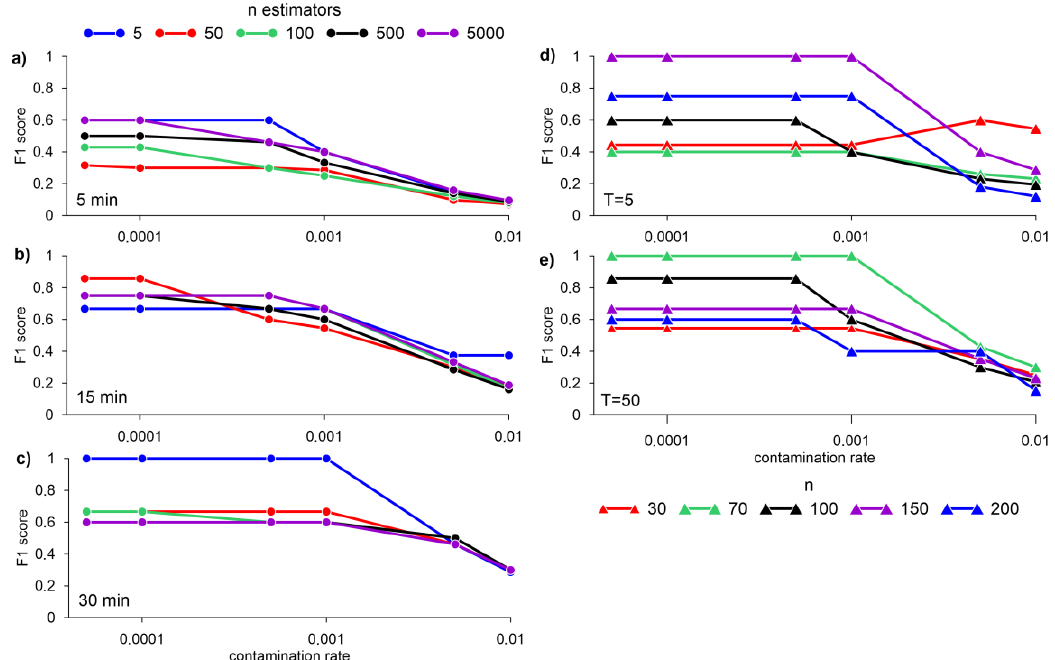
Figure 5. F1 score for different n-estimators with averaging data for 5 ( a ), 15 ( b ), 30 min ( c ), and normalizing using MinMaxScaler, max_samples = 256; different n, at T = 5 ( d ), and T = 50 ( e ) with 15-min data averaging obtained by the iForest algorithm.